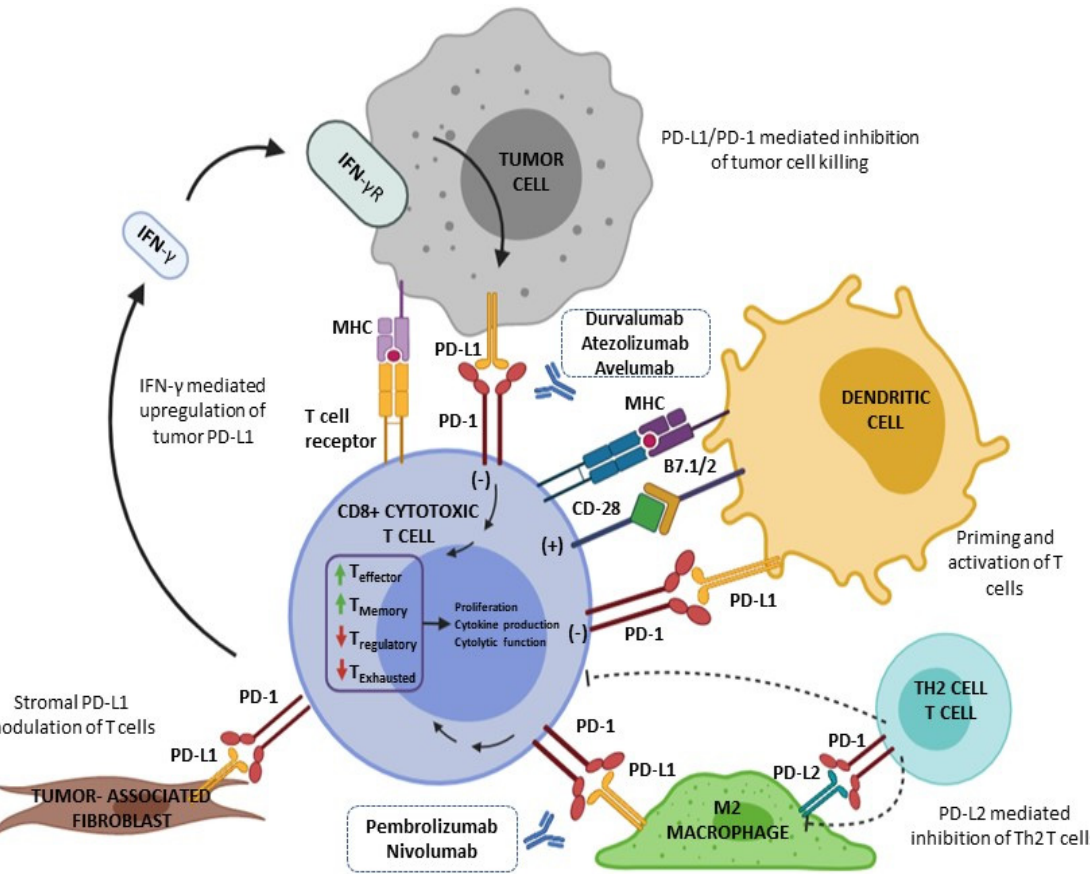
Figure 1. Mechanism of action of anti PD-1/L1. Activated T cells express PD-1, and when it binds to PD-L1/2 on tumor cells, it results in T-cell depletion. Durvalumab, avelumab and atezolizumab block PD-L1, while pembrolizumab and nivolumab block PD-1 to produce antitumor responses. In diagnostic routine, PD-L1 expression is measured by using IHC [18]. PD-L1 IHC slide is evaluated semi-quantitatively by the pathologist. A neoplastic cell is counted as PD-L1-positive if there is a membranous staining, irrespective of staining intensity and whether the membrane depicts complete or partial PDL1 expression. If there is cytoplasmic but no membranous staining, a tumor cell is considered PD-L1-negative. However, for immune cells, either granular cytoplasmic or membranous staining is enough for a positive count [18–20]. The antibody clone used for IHC, the percentage of PD-L1-positive immune cells, and/or tumor cells and the scores should be reported by the pathologist. The most relevant PD-L1 scores used in malignant tumors are tumor cell (TC), Tumor-Proportion Score (TPS), immune cell (IC), Immune-Cells Present (ICP), and Combined Positive Score (CPS) (Table 1) [7,18,21,22].